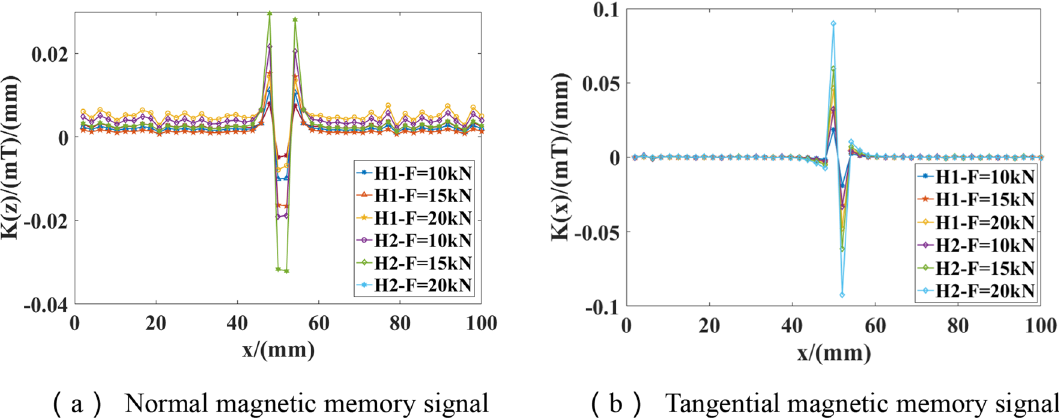
Fig. 12 Magnetic memory signal gradient changes under different pulling forces in the excitation magnetic field environment. a Normal magnetic memory signal. b Tangential magnetic memory